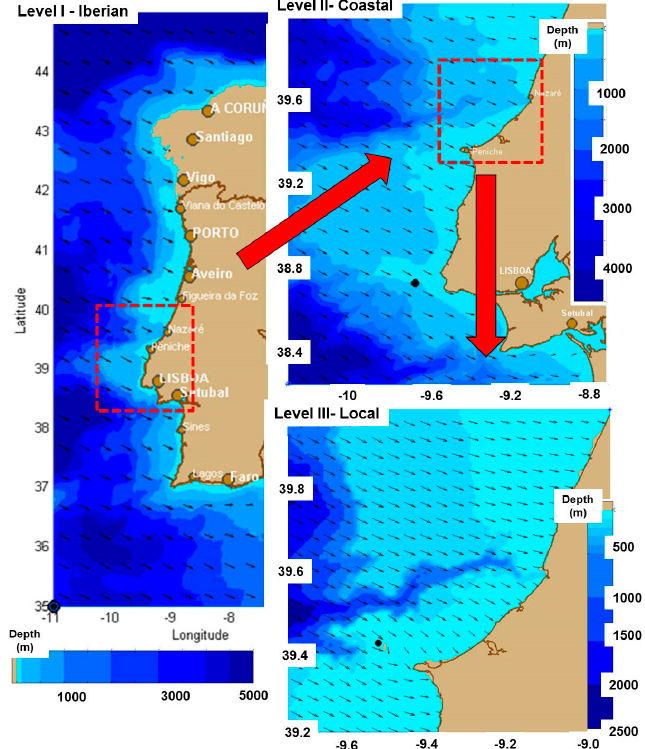
Figure 1. The geographical spaces of the first three computational domains considered for the SWAN model simulations (Levels I–III). In the background the bathymetry is represented, while in the foreground the most common pattern for the mean wave propagation is suggested. The meanings of the quantities used in SWAN are displayed in Table 1, and they are presented